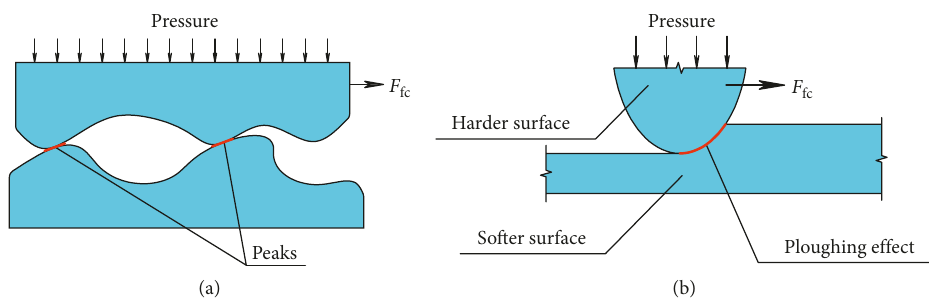
Figure 15: Adhesion friction and ploughing effect. (a) Adhesive friction; (b) ploughing